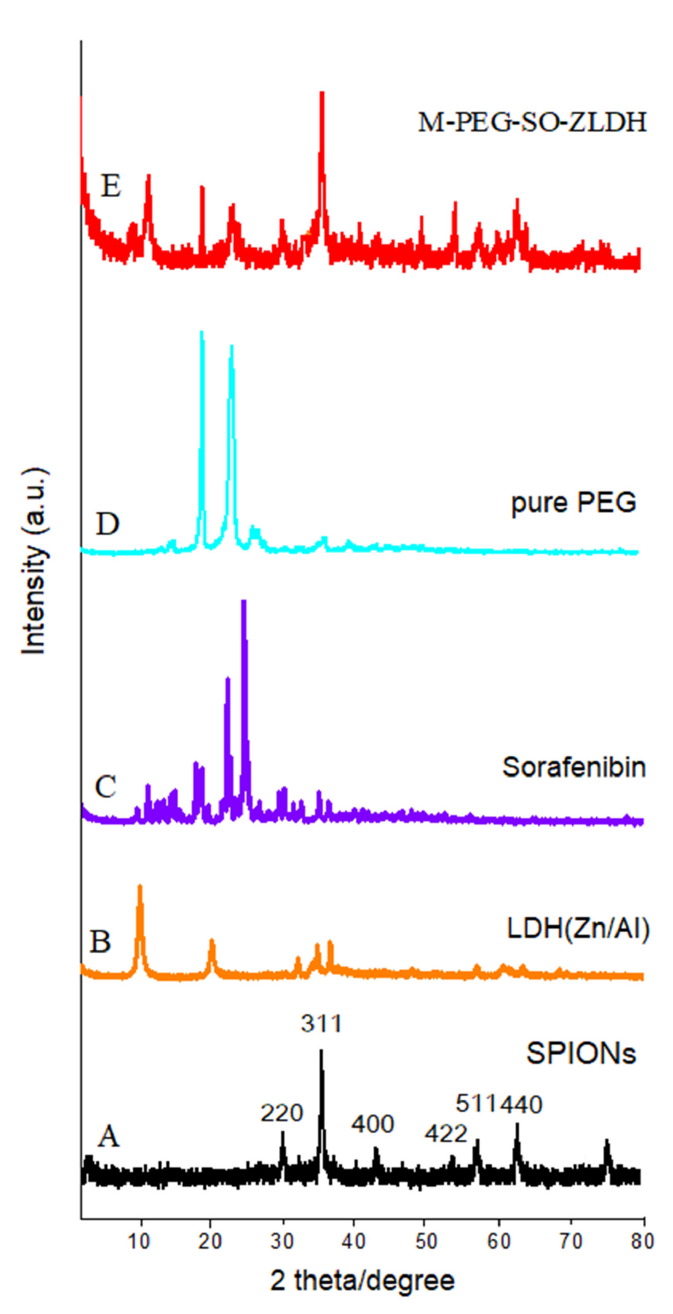
Figure 2. XRD patterns for ( A ) superparamagnetic iron oxide nanoparticles; ( B ) pure layered double hydroxide (LDH) (Zn / Al); ( C ) pure sorafenib; ( D ) pure PEG, ( E ) drug-loaded magnetic nanoparticles (M-PEG-SO-ZLDH).